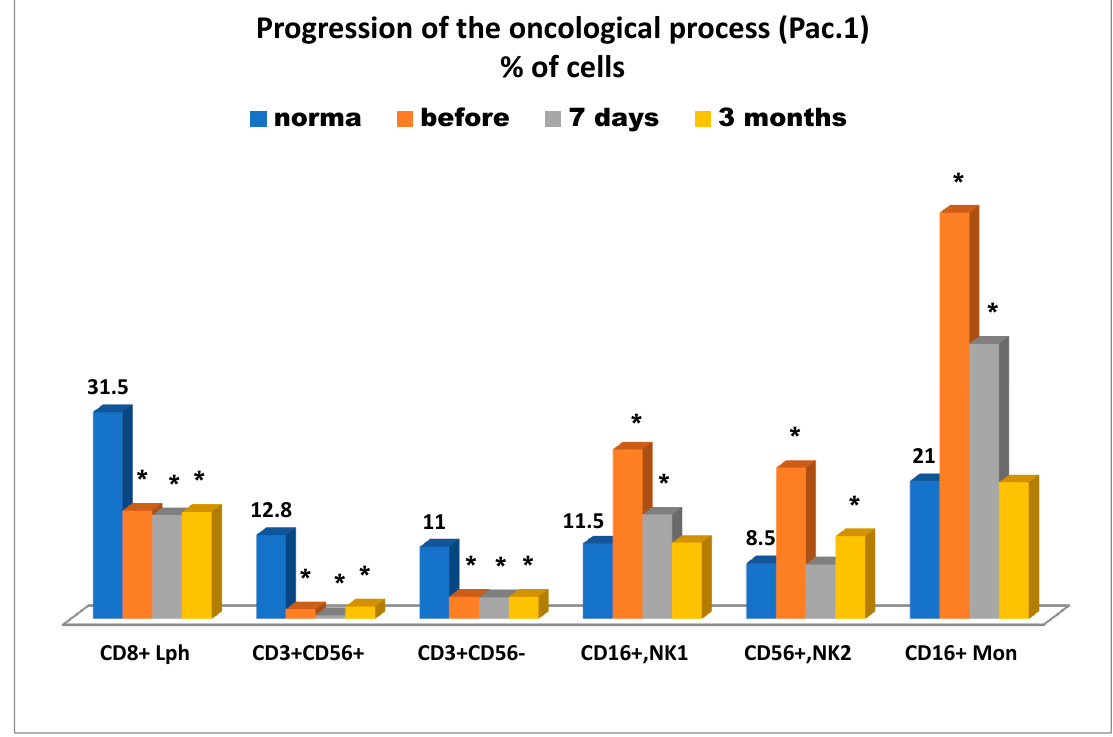
Figure 5. Progression of the oncological process in Patient 1; percentage of cells. Legend: * significance of differences; Lph = lymphocytes; Mon = monocytes; NK = natural killer cells; CD8 = cytotoxic T8-Lph; CD3+CD56+ = natural killer effector; CD3+CD56 = natural killer regulator; CD16+ Mon = Monocyte K-cell; number of days and months = after operation.